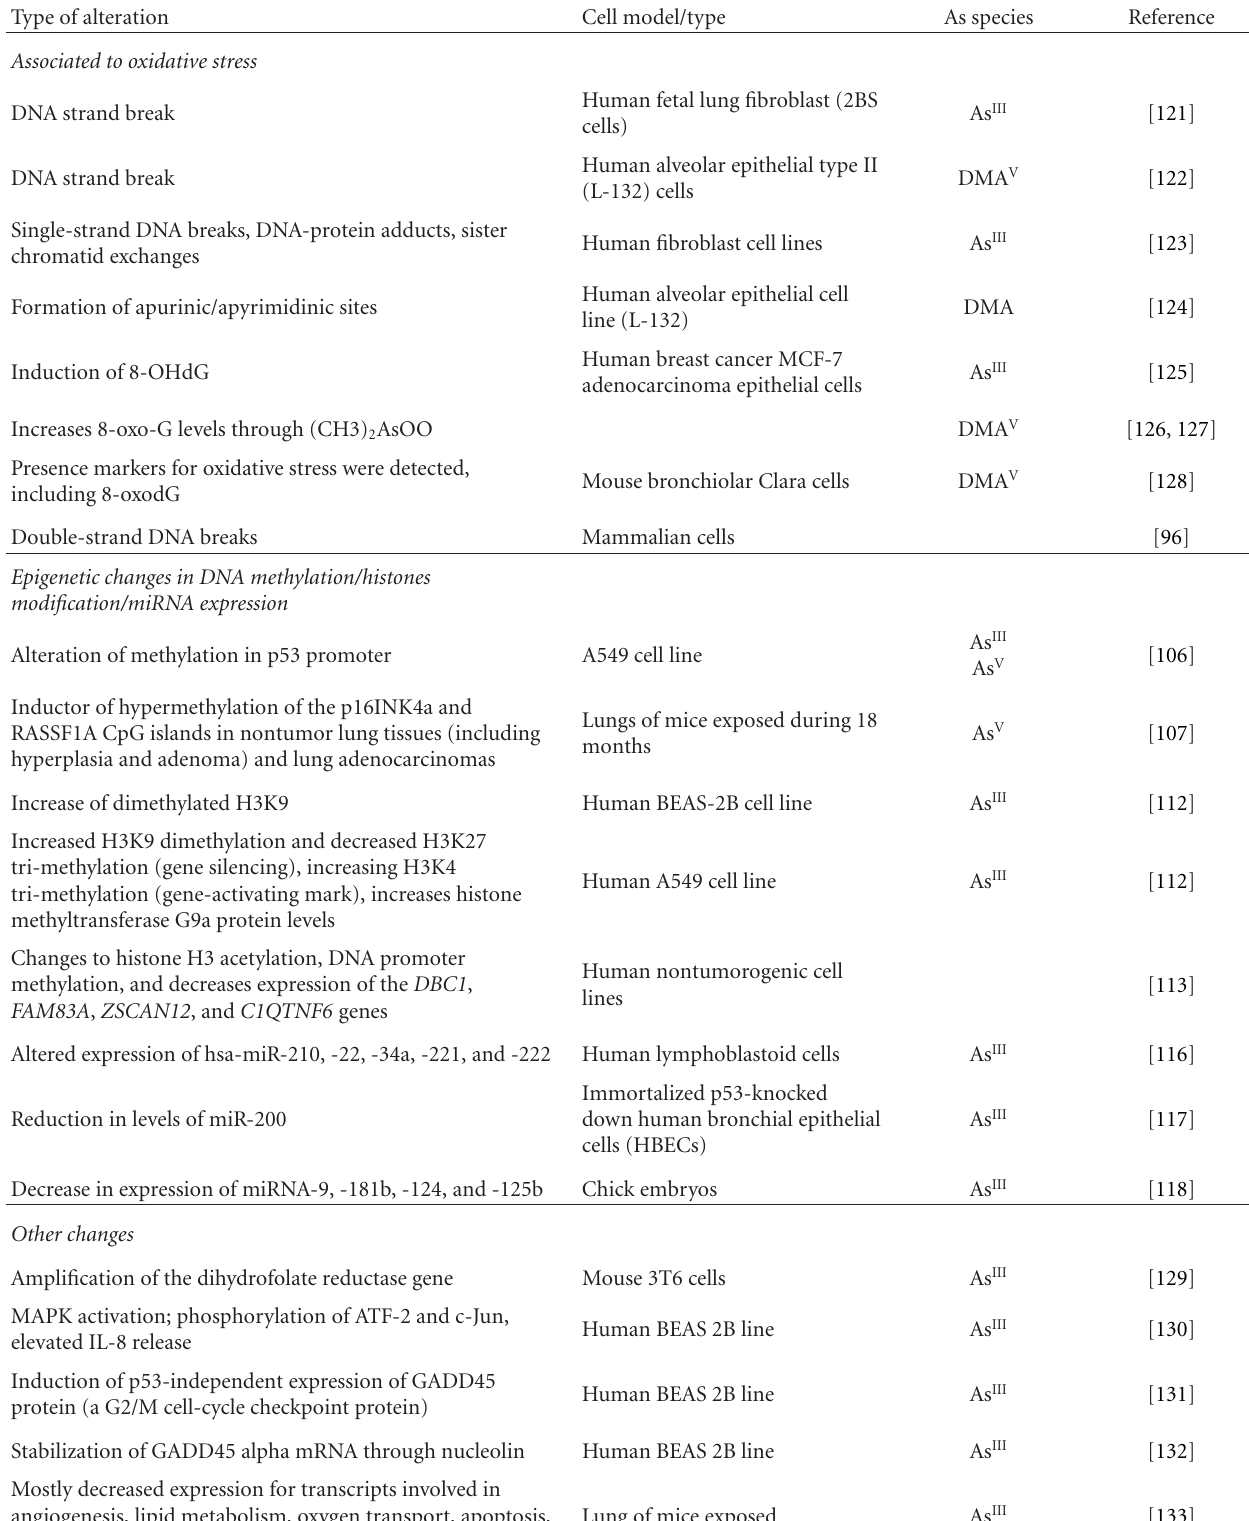
Table 1: Changes in functions associated to arsenic-related